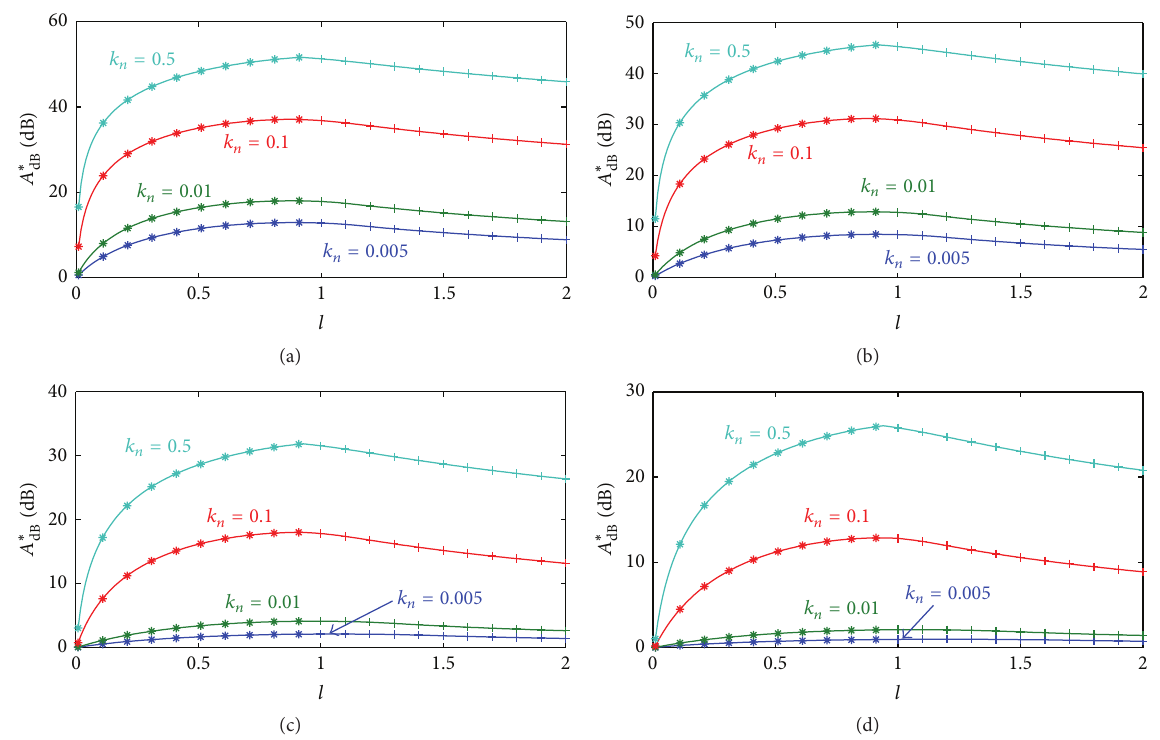
Figure 6: Relationship between 𝐴 ∗ dB and 𝑙 for different 𝑘 𝑛 values and different 𝜉 𝑛 values: 0.05% (a), 0.1% (b), 0.5% (c), and 1% (d). The + are the points related to the case of 𝑙 > 1 calculated using (29), (19), and (17), which are then interpolated by fourth-order polynomials (solid curves). The ∗ are the points related to the case of 𝑙 < 1 calculated using (29), (19), and (17), which are then interpolated by fourth-order polynomials (solid curves).